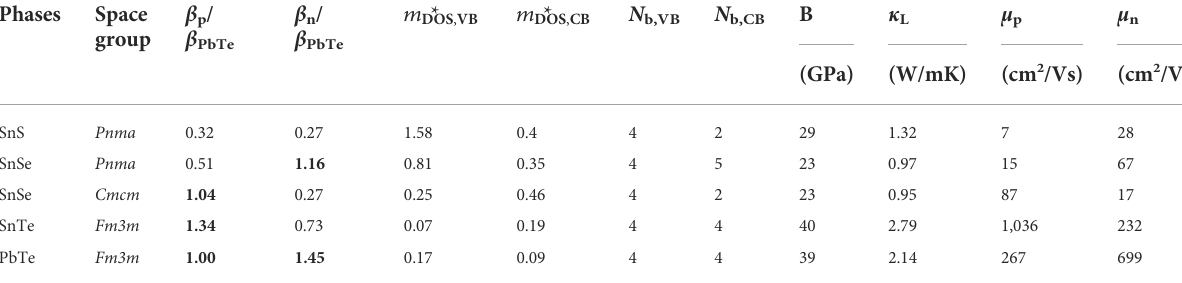
TABLE 1 Computed transport properties and thermoelectric quality factor β at 300 K for SnS, SnSe, and SnTe obtained from semi-empirical models (Yan et al., 2015; Miller et al. 2017). For each Sn chalcogenide, β is normalized to the corresponding value for p-type PbTe (44.15). For p-type materials, SnSe ( Cmcm ) and SnTe have TE quality factor exceeding that of p-type PbTe; for n-type materials only SnSe ( Pnma ) has TE quality factor exceeding p-type PbTe. Phases